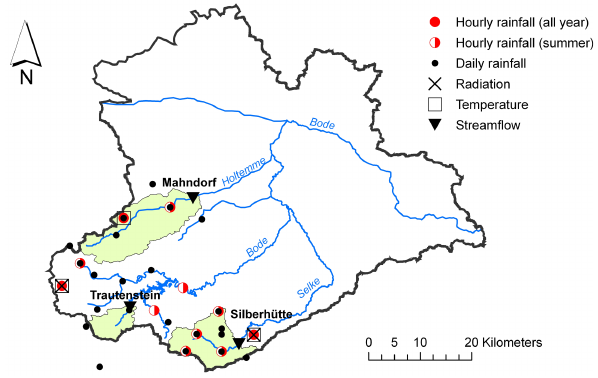
Fig. 6. Study area with the three selected catchments, precipitation stations, climate stations and stream flow